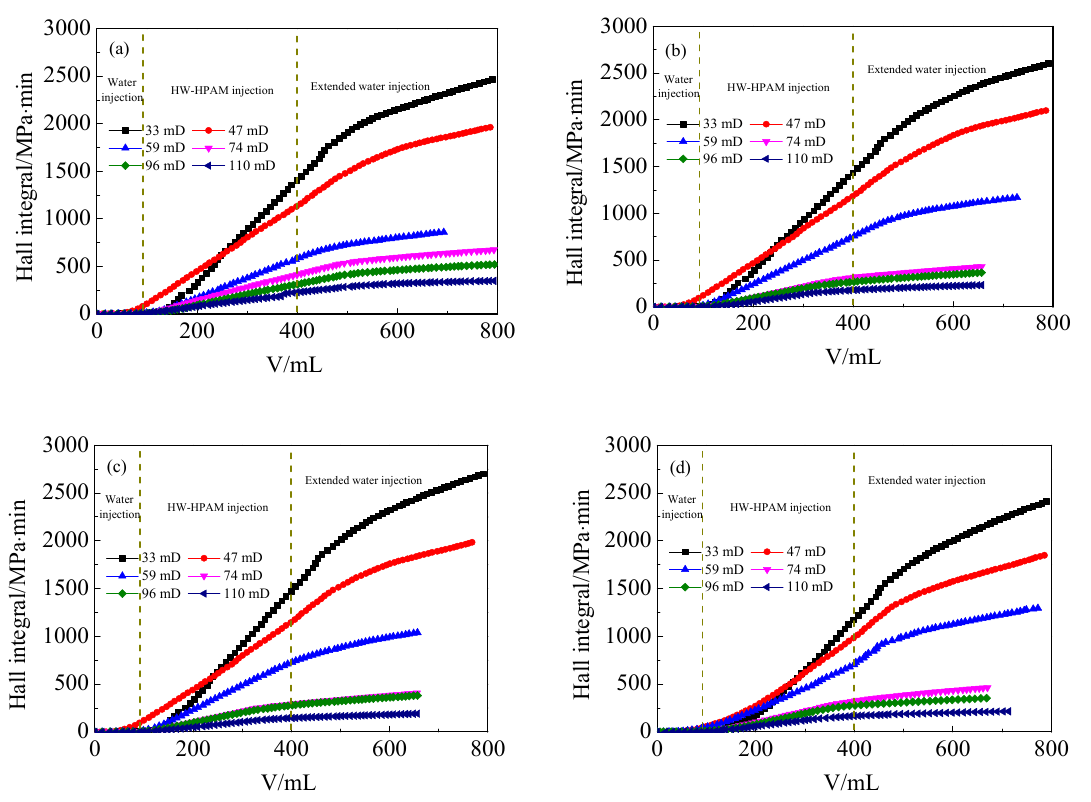
Figure 12. Hall curves of different concentrations of HW-HPAM under different permeability core conditions. V: Cumulative injection. ( a ) 0.8 g · L − 1 , ( b ) 1.5 g · L − 1 , ( c ) 2.3 g · L − 1 and ( d ) 3.0 g · L − 1 .